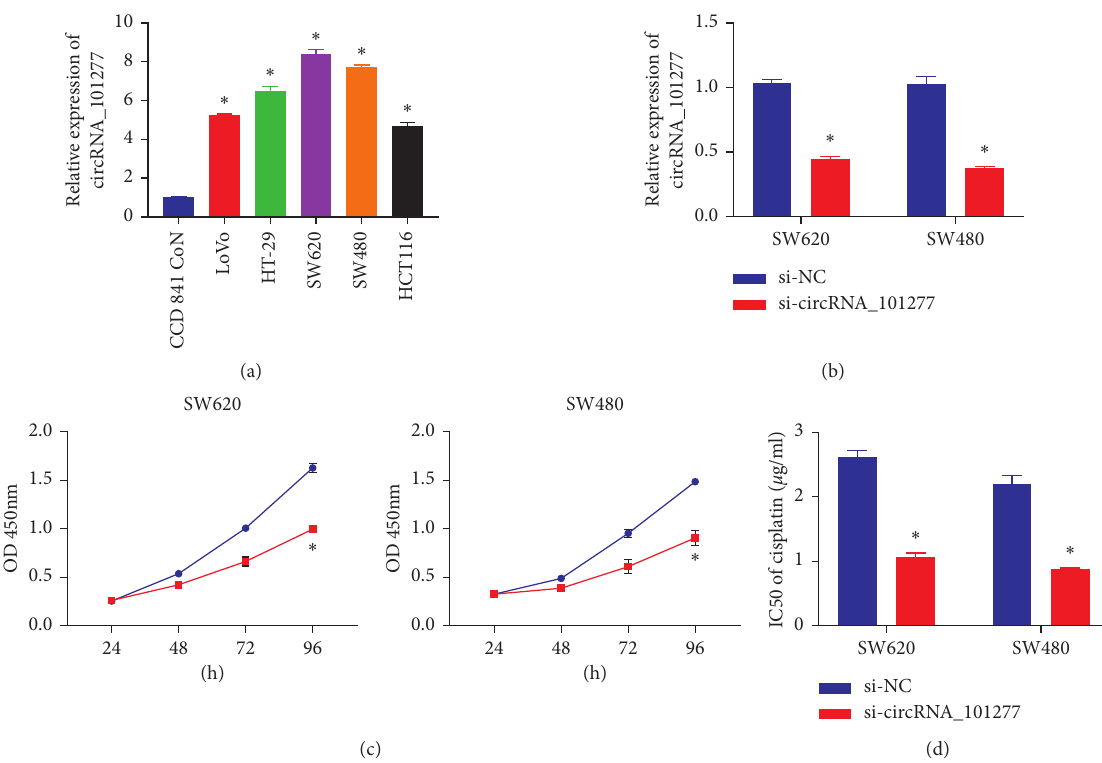
Figure 2: circRNA_101277 downregulation overcomes CRC cisplatin resistance. (a) circRNA_101277 levels in CRC cells were measured. (b) circRNA_101277 knockdown was achieved in SW620 and SW480 cells. (c) circRNA_101277 knockdown impaired SW620 and SW480 cellular proliferation. (d) circRNA_101277 downregulation decreased the IC50 of cisplatin in CRC cells. ∗ p <